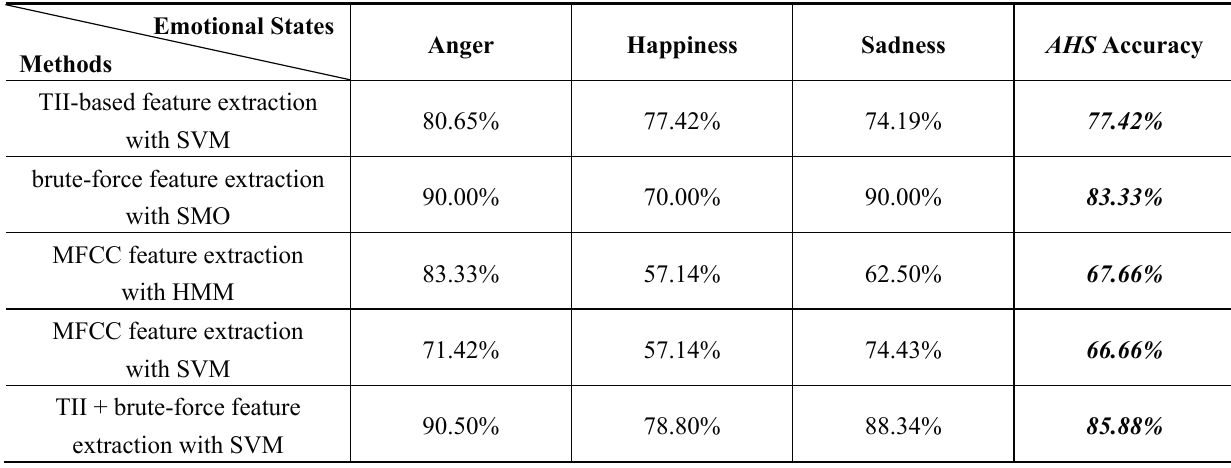
Table 13. The comparison evaluation of ESS for three common emotional